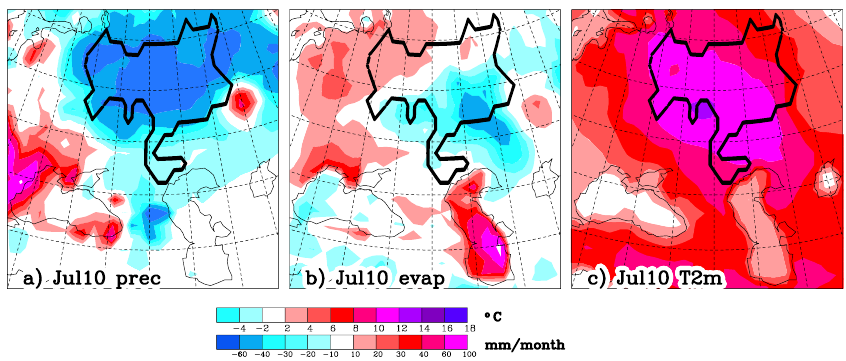
Fig. 5. Anomaly maps using ERA data. A black line indicates the Volga catchment area. (a) precipitation for July 2010; units: mmmonth − 1 , (b) evaporation for July 2010; units: mmmonth − 1 and (c) temperature for July 2010; units: ◦ C. Red colours: increase, blue colours: decrease. Table 5. Anomaly correlations of monthly means between Caspian Sea level (CSL) change, ENSO index (ONI), Volga River dis- charge (VRD) and precipitation over the Volga basin